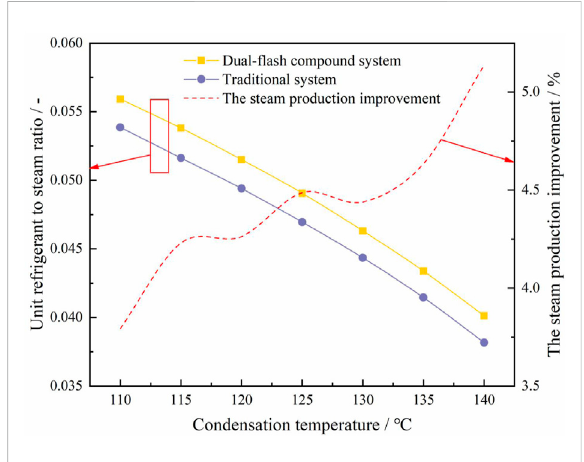
FIGURE 11 The change of unit steam volume of the system at different condensing